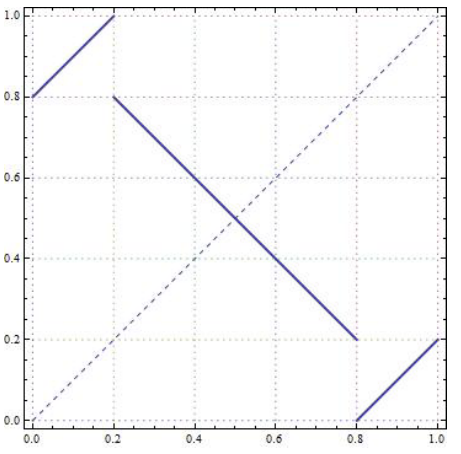
Figure 6. Graph of a ( 3,1 ) -IET with permutation ( 3, − 2,1 ) and a =